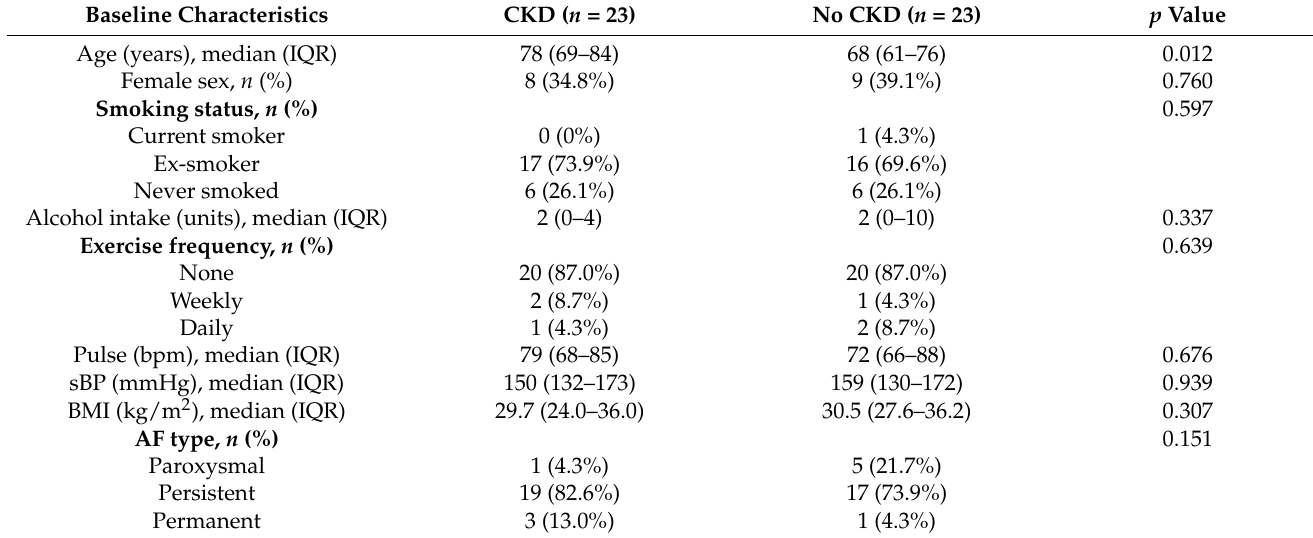
Table 2. Baseline characteristics of AF patients with and without chronic kidney